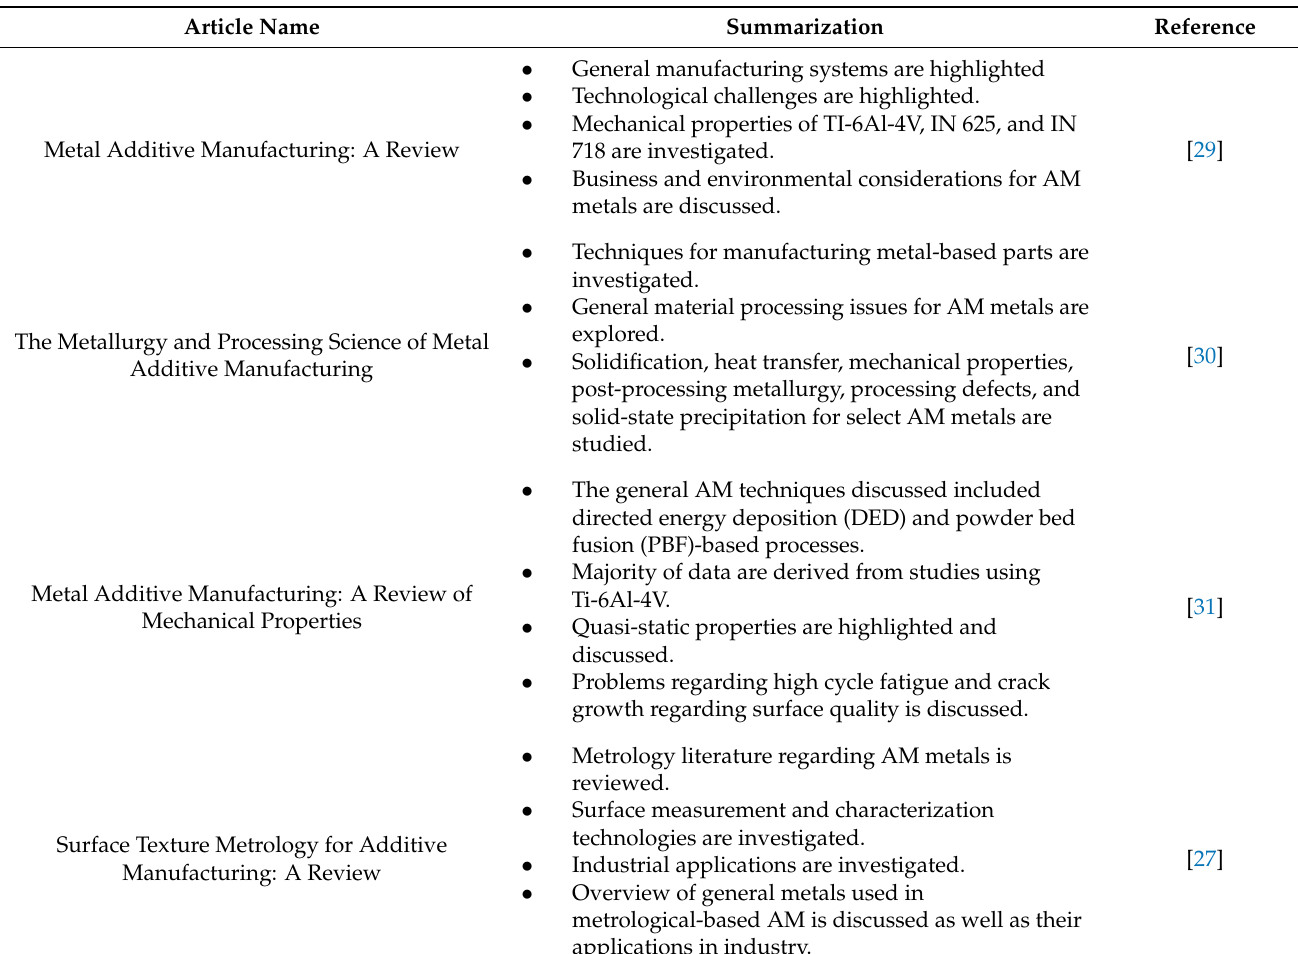
Table 1. Publications relating to mechanical, tribological, metrological, and energy preserving enhancements of additive manufacturing (AM)